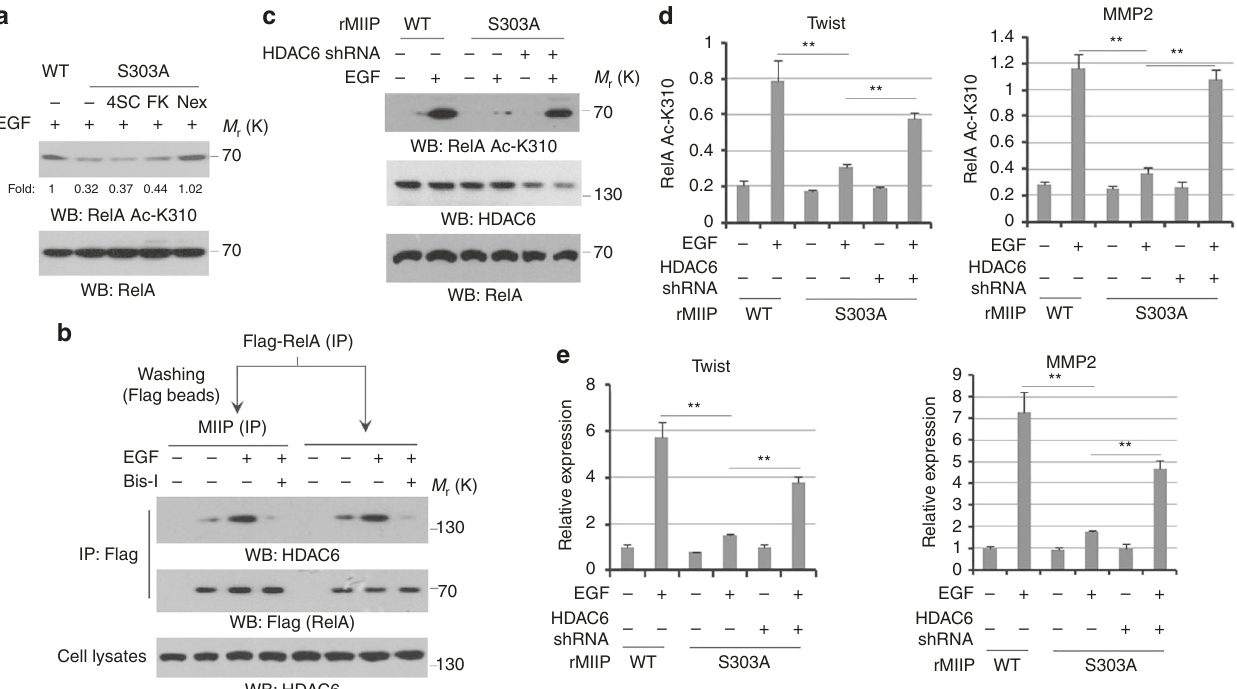
Fig. 4 MIIP prevent HDAC6-mediated RelA deacetylation. a HCT116 cells were pretreated with or without 4SC-202 (0.6 μ M), FK228(20 nM) and Nexturastat A (5 nM) for 1 h prior to EGF (100 ng/ml) treatment for 30 min. Immunoblotting analyses were performed. b HCT116 cells were pretreated with or without Bis-l for 1 h prior to EGF (100 ng/ml) treatment for 30 min. Cellular extracts subjected to immunoprecipitation with an anti-Flag, followed by Flag-beads washing and a second immunoprecipitation with an anti-MIIP (lanes 1 – 4 from left). Cellular extracts subjected to immunoprecipitation with an anti-Flag (lanes 5 – 8 from left). c – e HCT116 cells expressed with WT MIIP or MIIP S303A were overexpressed with or without HDAC6 shRNA; cells were treated with or without EGF (100 ng/ml) for 10 h. Immunoblotting analyses were performed ( c ). ChIP analyses with an anti-RelA Ac-K310 antibody were performed. The primers covering RelA binding site of Twist or MMP2 gene promoter region were used for the q-PCR. The Y axis shows the value normalized to the input. d Relative mRNA levels were analyzed by q-PCR ( e ). In a – c , immunoblotting analyses were performed using the indicated antibodies and data represent one out of three experiments. In d , e , the values are presented as mean ± s.e.m. ( n = 3 independent experiments), ** represents P < 0.01 (Student ’ s t -test) between the indicated